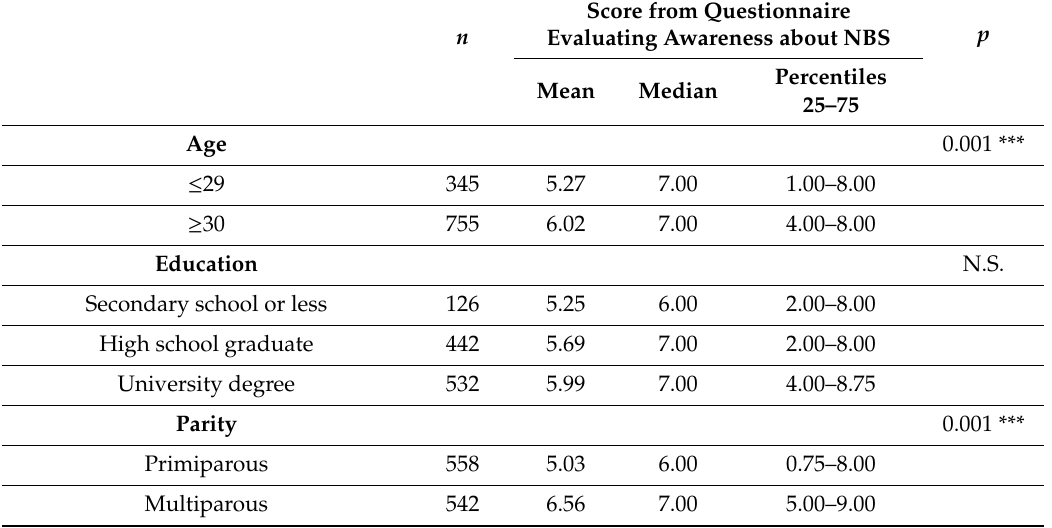
Table 2. Analysis of the determinants associated with score from the questionnaire evaluating awareness about NBS (statistical significance *** p < 0.001; * p < 0.05). Score from Questionnaire Evaluating n